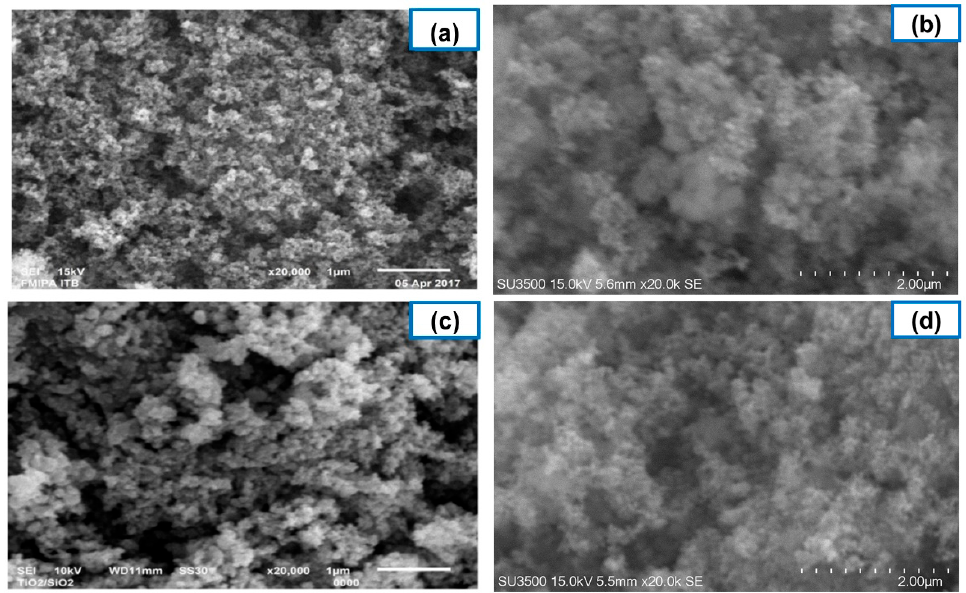
Figure 3. Surface morphology of ( a ) TiO 2 P25 [32], ( b ) TiO 2 /SiO 2 composite 1:1 ratio, ( c ) TiO 2 /SiO 2 composite 3:1 ratio, and ( d ) TiO 2 /SiO 2 composite 7:1 ratio.